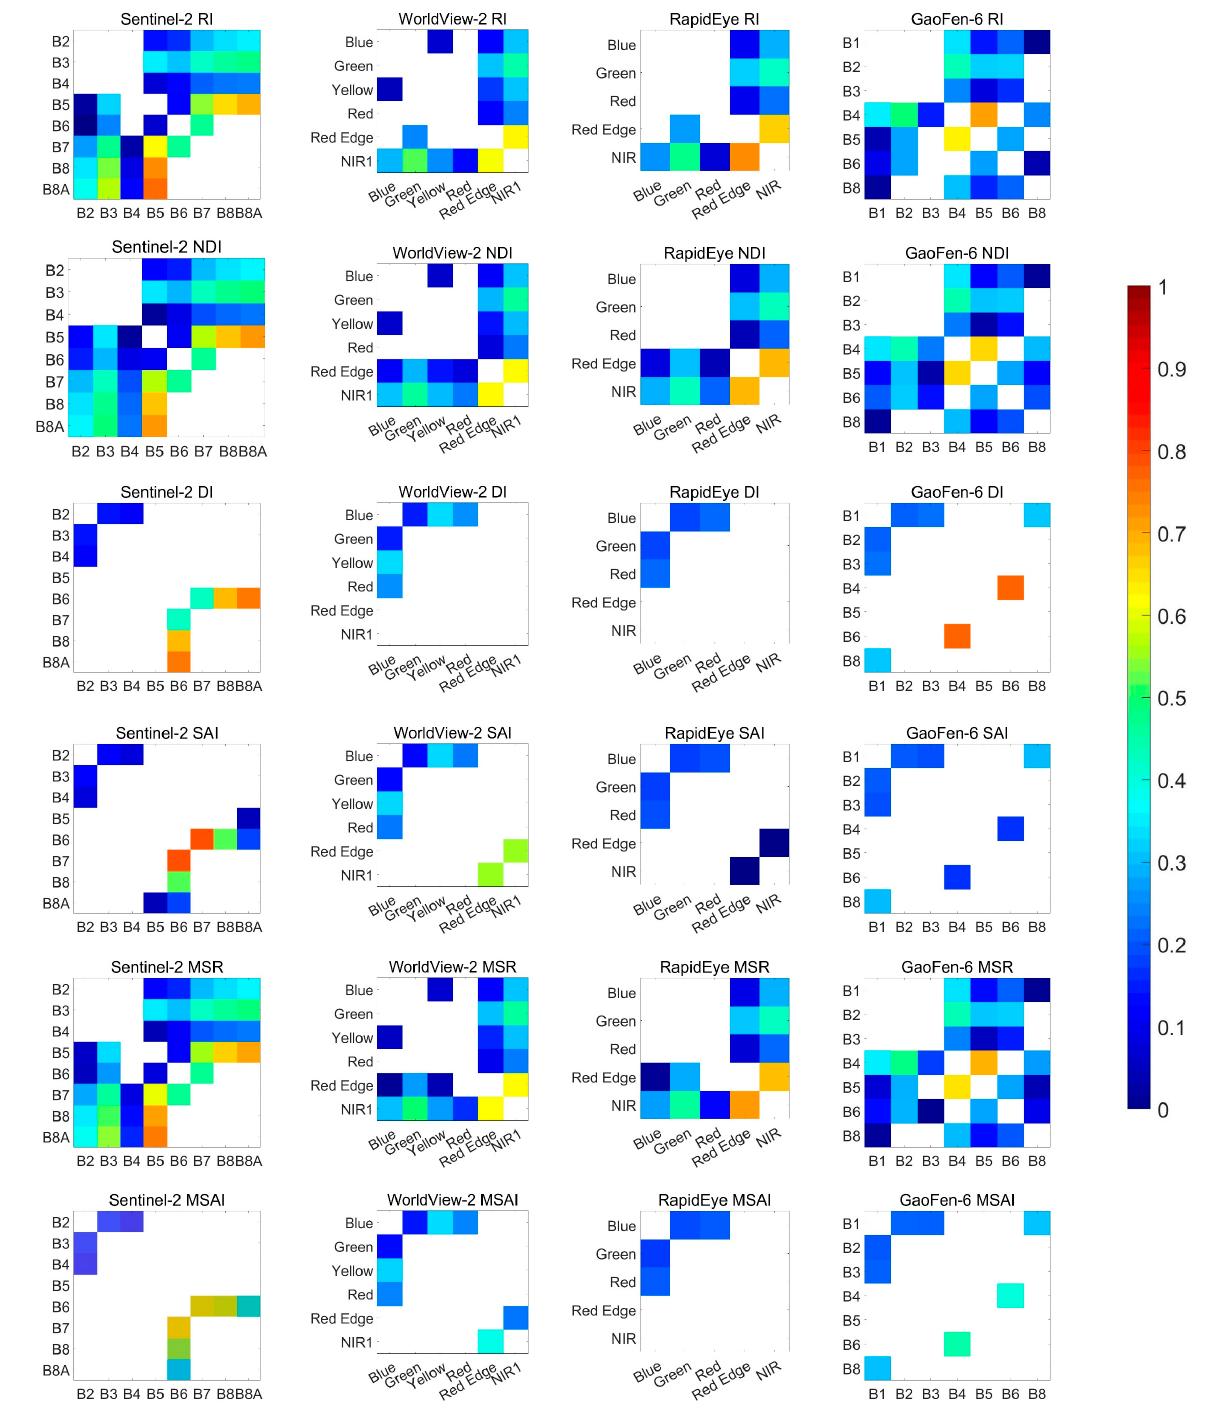
Figure 4. Matrices of difference between R 2CCC and R 2MTA in all possible two band combinations for RI, NDI, DI, SAI, MSR and MSAI formulations. The color indicates different R 2 values, blank negative values.